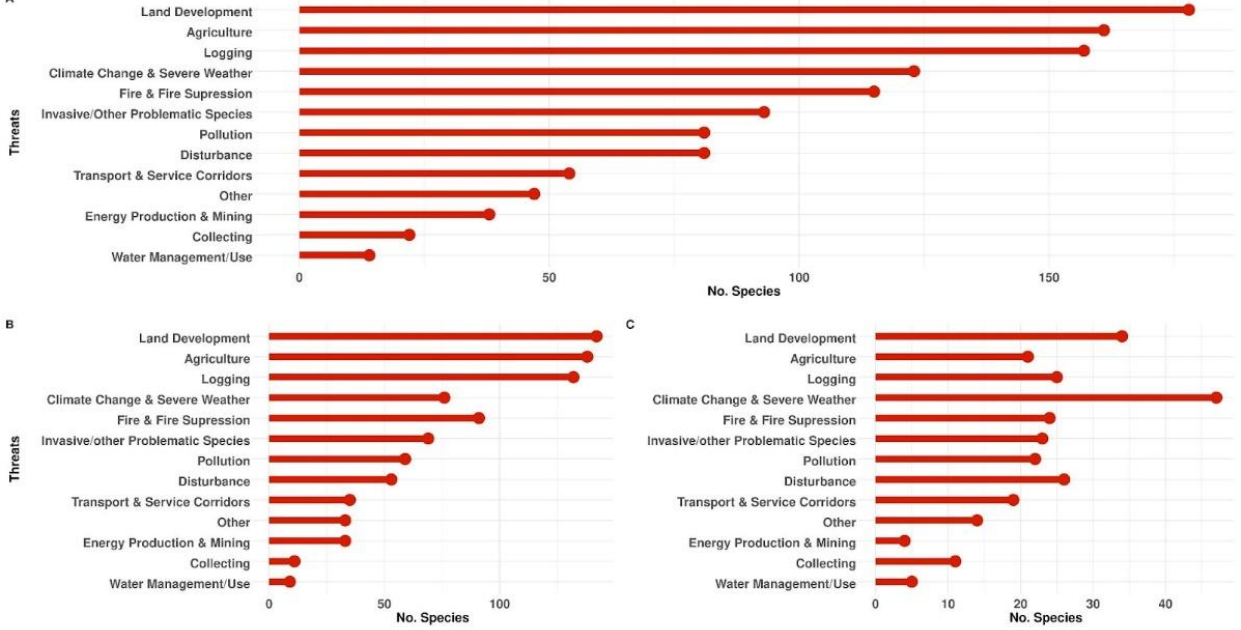
Figure 10. Threats identified for globally threatened and near-threatened: ( A ) all fungi (n = 345); ( B ) nonlichenized fungi; ( C ) lichens. This compilation was based on the qualitative listing of threats for each assessed species, and the relative size of the bars does not reflect the relative significance of each threat. NT species are included, as understanding their threats is needed to mitigate further population loss.